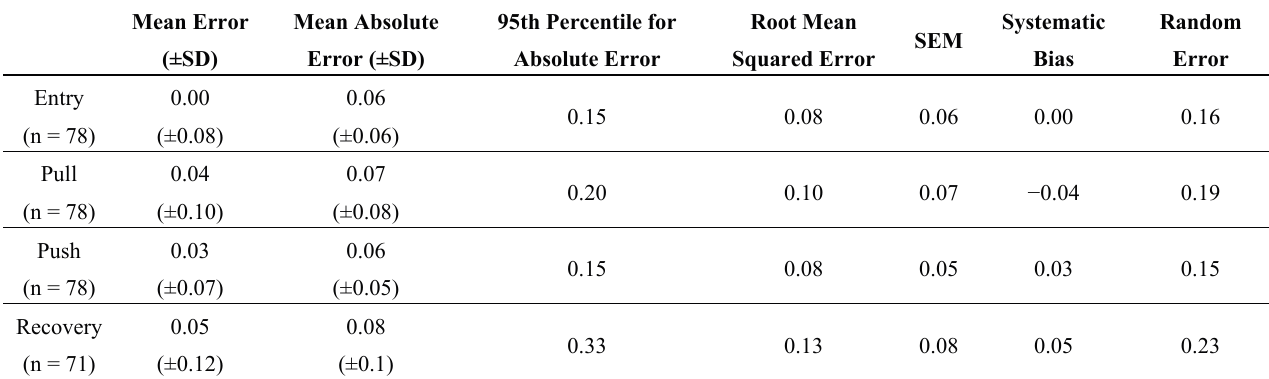
Table 3. Reliability statistics for Phase durations. All results presented in